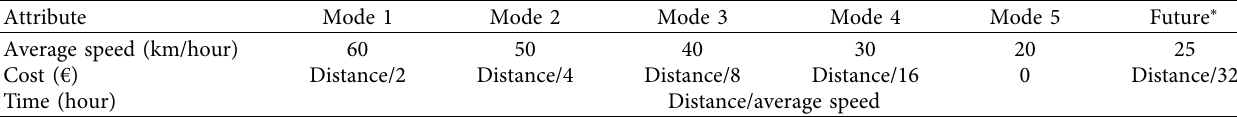
Table 2: Synthetic dataset mobility system attributes.